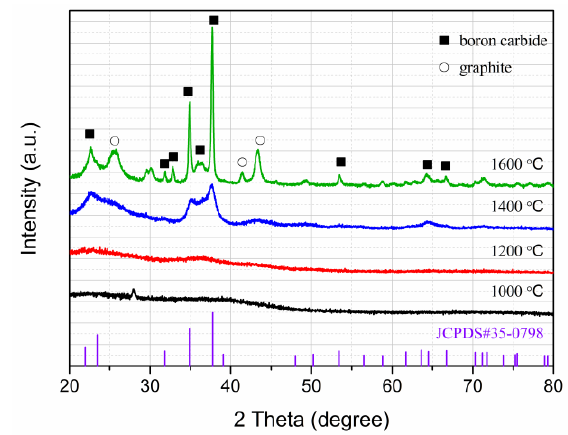
Figure 7. XRD patterns of the P(ND- co -D) derived ceramics at different temperatures.